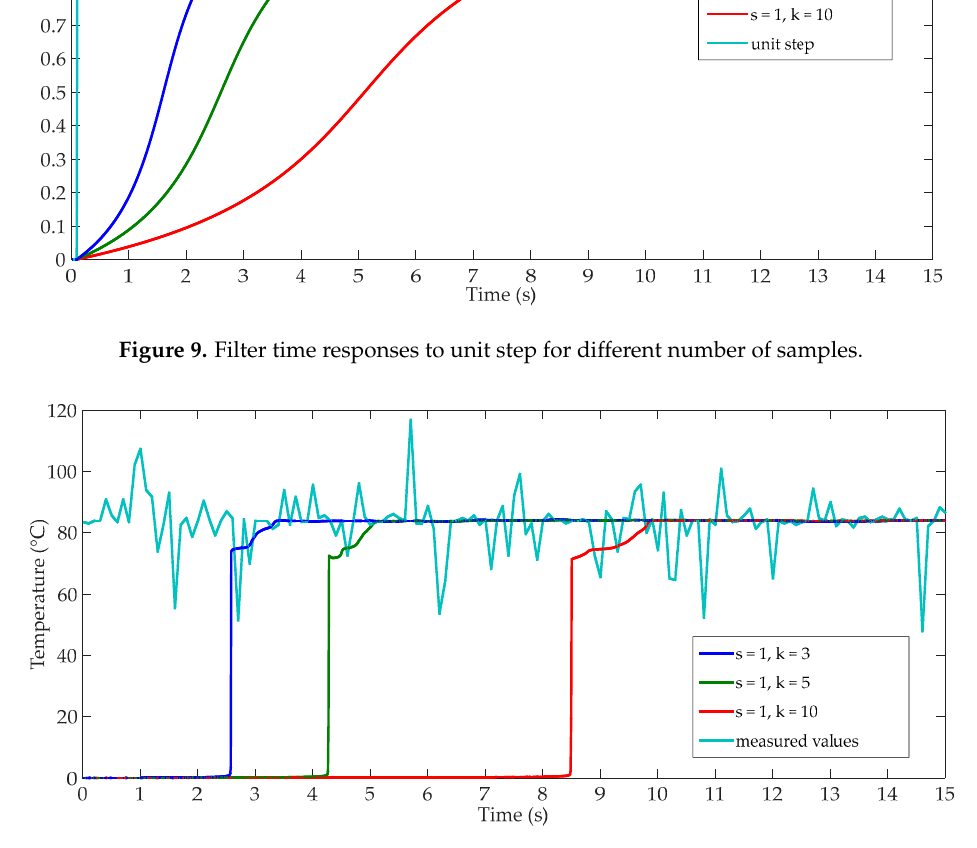
Figure 10. Filtering of the noisy measured variable for different number of samples.